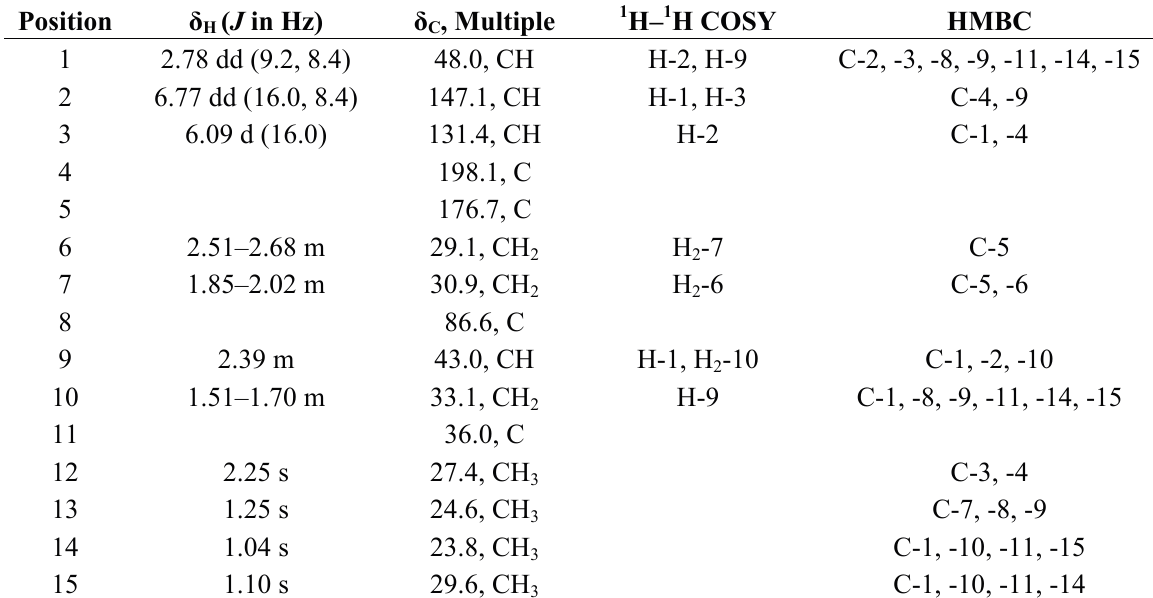
Table 1. 1 H (400 MHz, CDCl and HMBC correlations for rumphellaone B ( 1